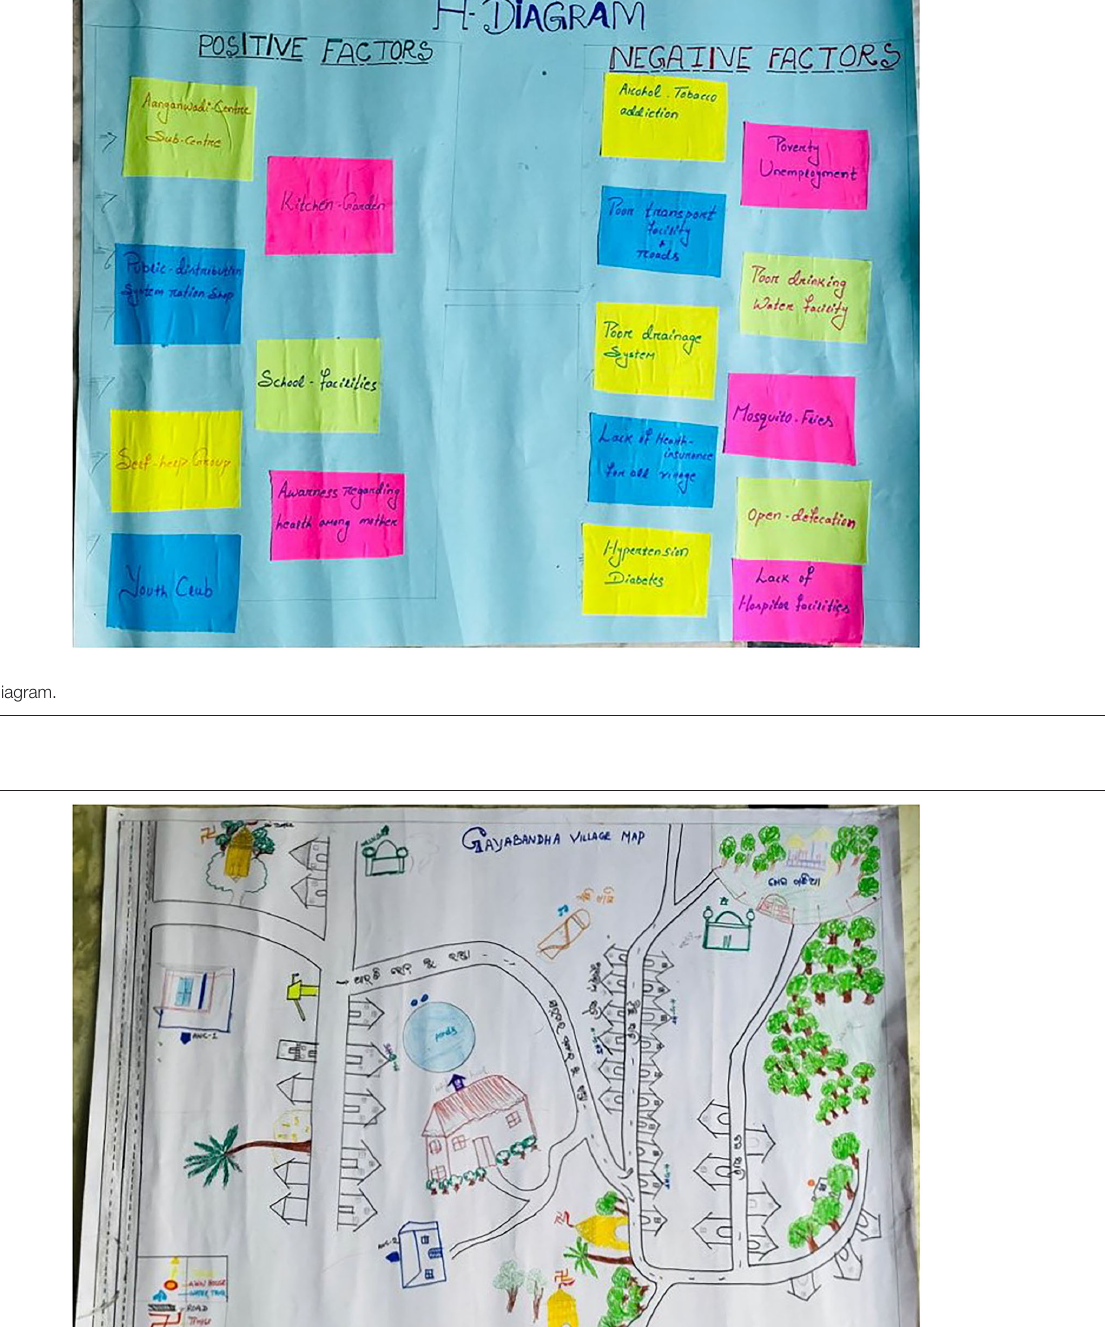
Frontiers in Public Health |